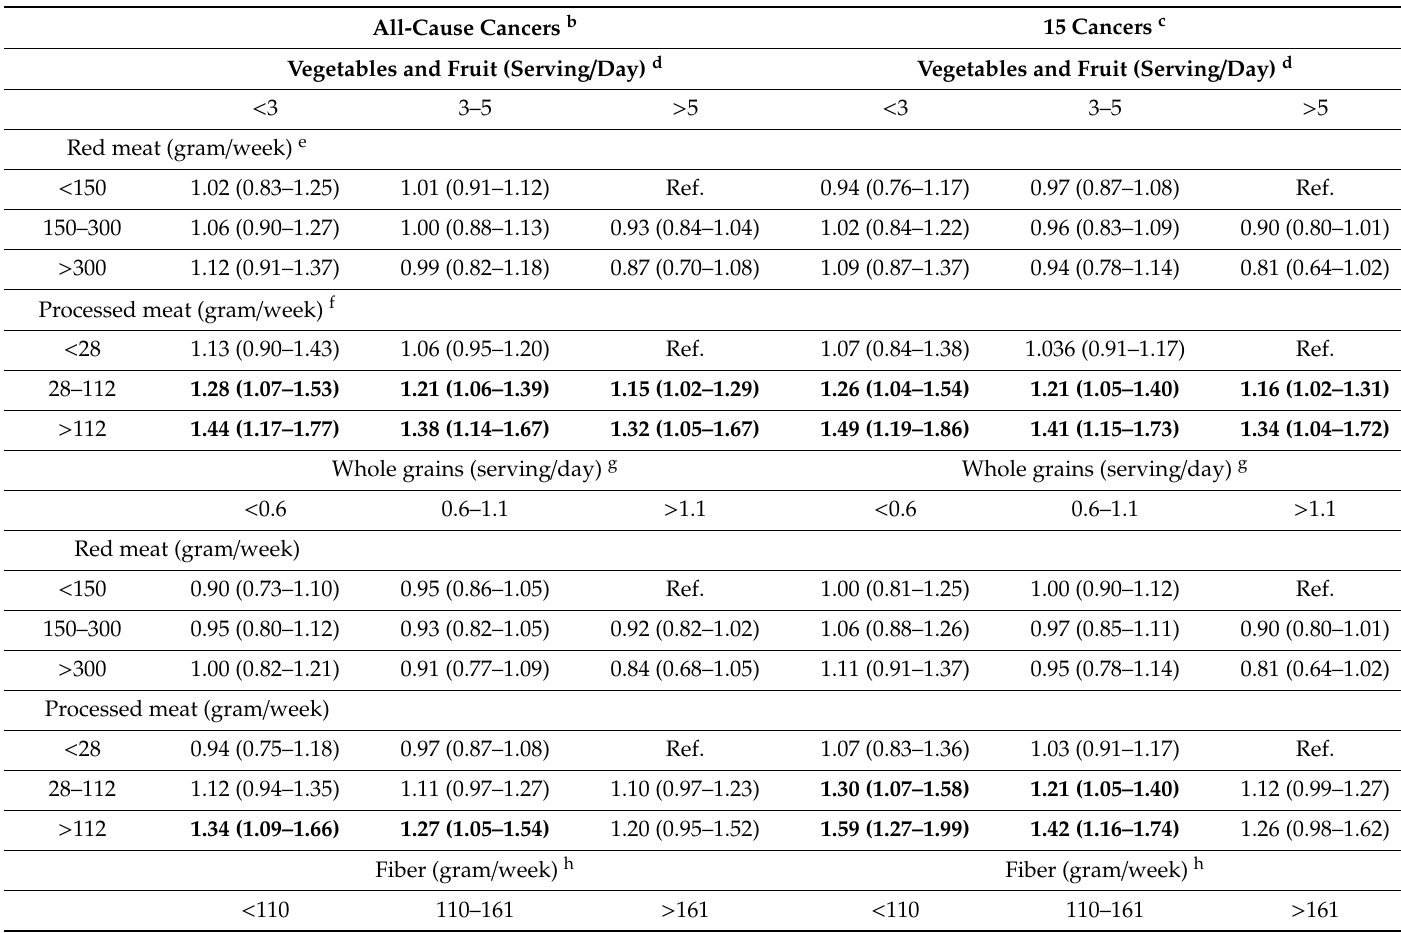
Table 3. Estimated hazard ratios a and confidence intervals for all-cause and 15 cancer incidence for di ff erent combinations of intake levels of red and processed meat with vegetables and fruit, whole grains, and fiber among women, Alberta’s Tomorrow Project ( n =